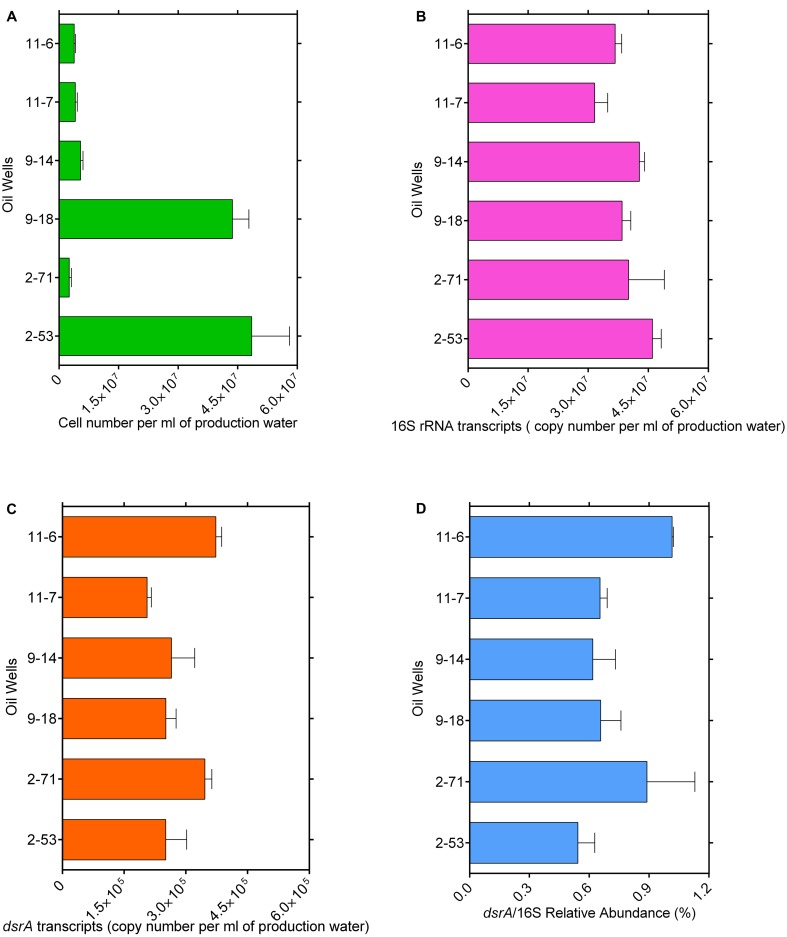
Total microbial cell numbers (A), gene transcript levels of bacterial 16S rRNA (B) and dsrA
(C) from each well with different corrosion rate, ratios of dsrA/16S rRNA copy number (D). Error bars represent standard errors of the means across three replications.